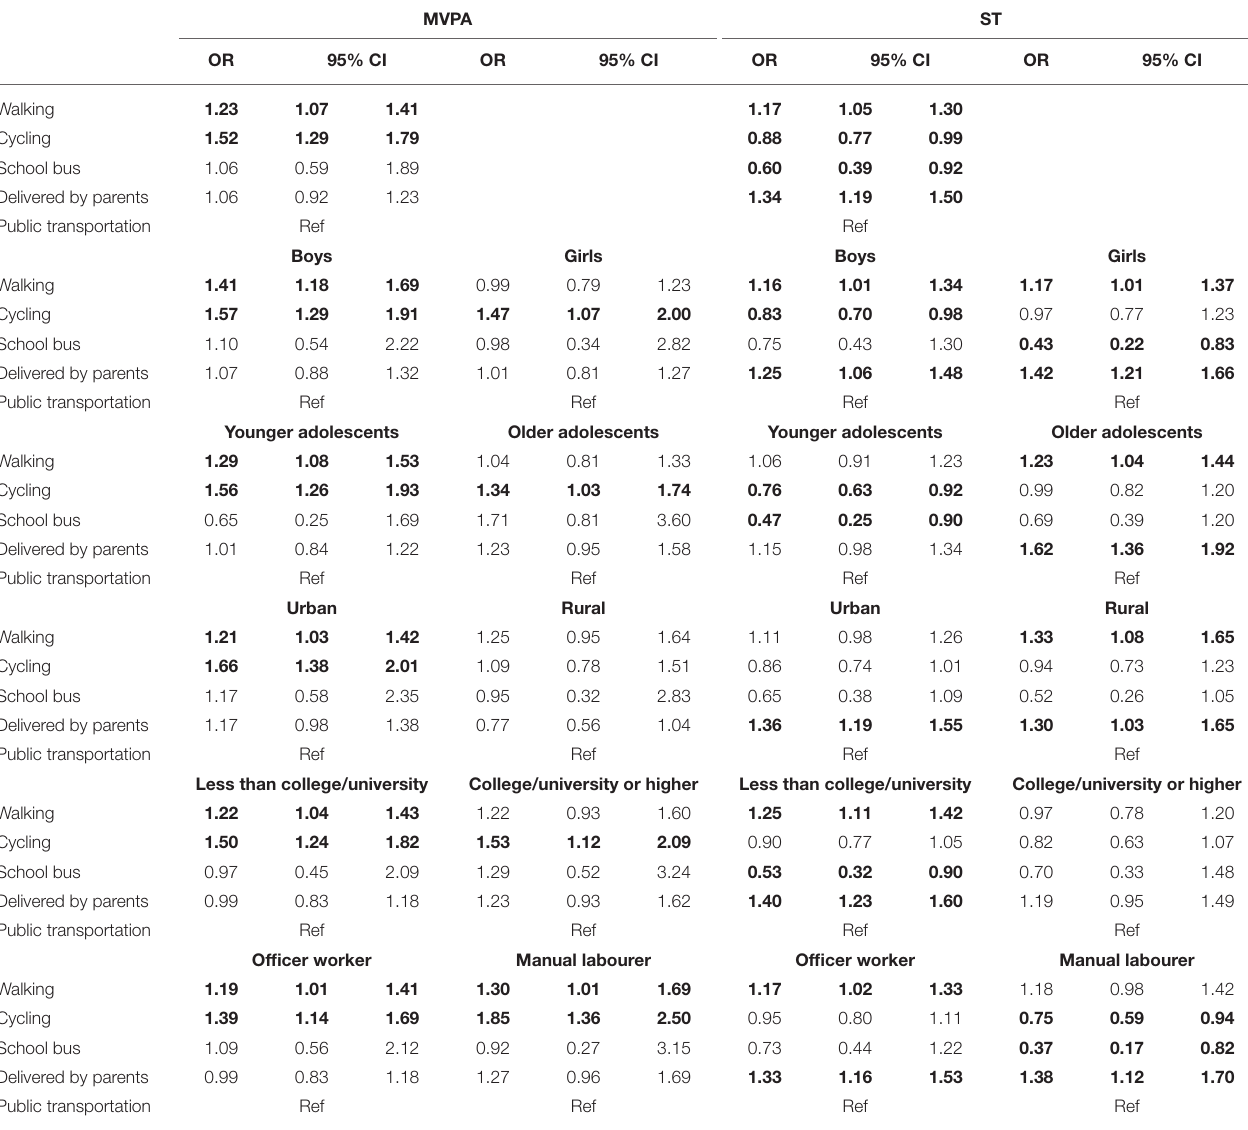
TABLE 6 | The relationships of types of active travel to school with MVPA and ST by different characteristics. MVPA ST OR 95% CI OR 95% CI OR 95% CI OR 95%